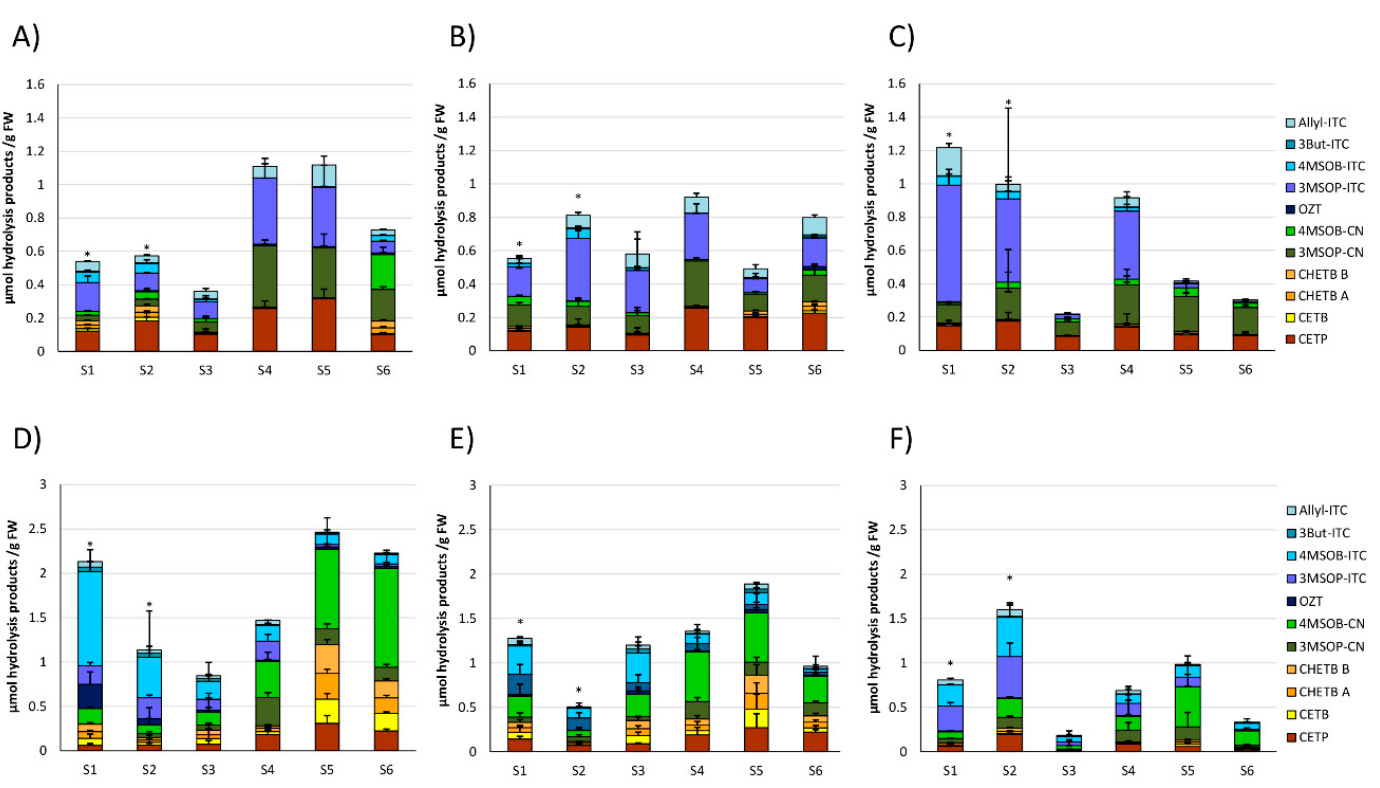
Figure 2. Main glucosinolate (GLS) hydrolysis products released from white ( A – C ) and red cabbages ( D – F ) from conventional ( A , B , D , E ) and organic supermarkets ( C , F ) on di ff erent sampling dates (S1–S6). Exact sampling dates can be found in Table 1. ( A , D ) Represent conventional supermarket 1 (CON 1 ), ( B , E ) stand for conventional supermarket 2 (CON 2 ), and ( C , F ) show results from organic supermarket 1 (ORG 1 ). Each color in the bar of the given bar chart represents the mean plus standard deviation (SD) of the GLS hydrolysis products from three cabbage heads from the same supermarket ( n = 3). Abbreviations: FW: Fresh weight; abbreviations of compounds are listed in Table 3. * Samples were analyzed from 1 g of sample homogenate (instead of 0.5 g).